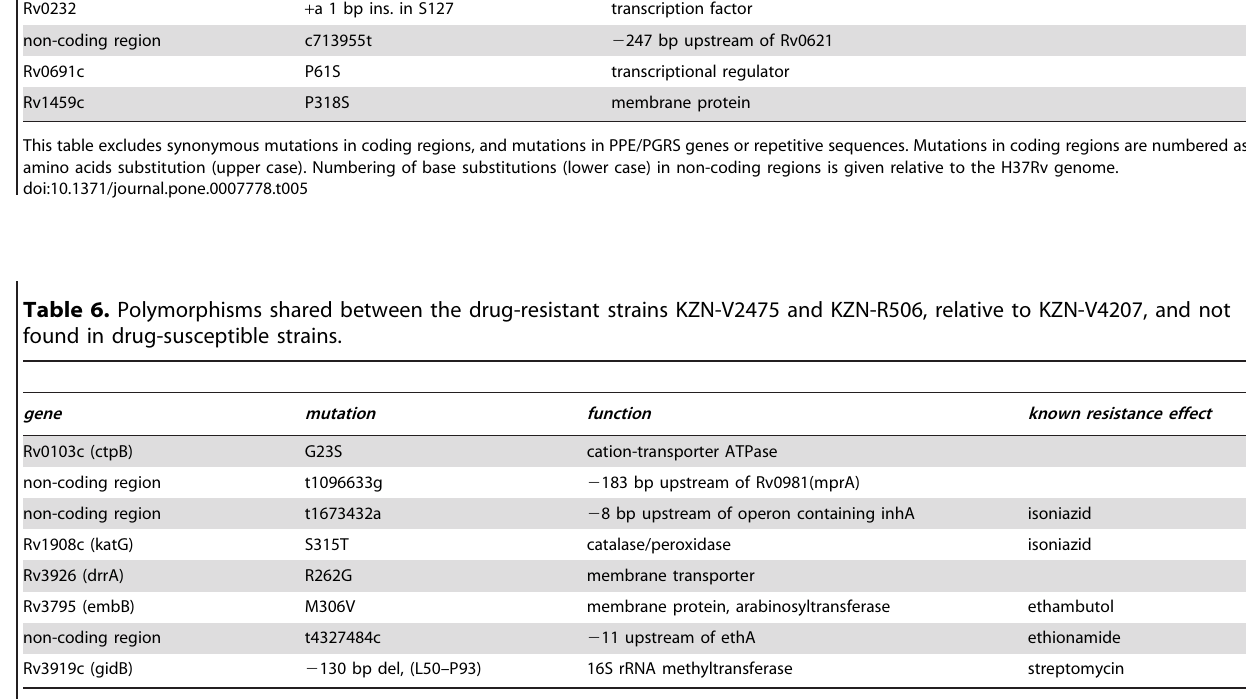
This table excludes synonymous mutations in coding regions, and mutations in PPE/PGRS genes or repetitive sequences. Mutations in coding regions are numbered as amino acids substitution (upper case). Numbering of base substitutions (lower case) in non-coding regions is given relative to the H37Rv